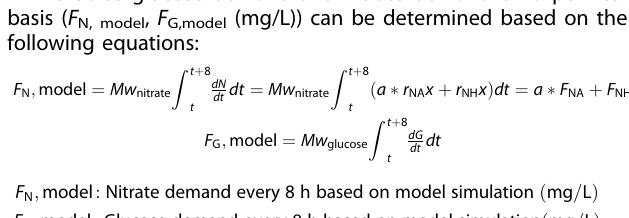
During the experiment, biomass levels ( x m ), glucose levels ( G m ) and nitrate levels ( N m ) were msured and used as inputs into the closed-loop system.